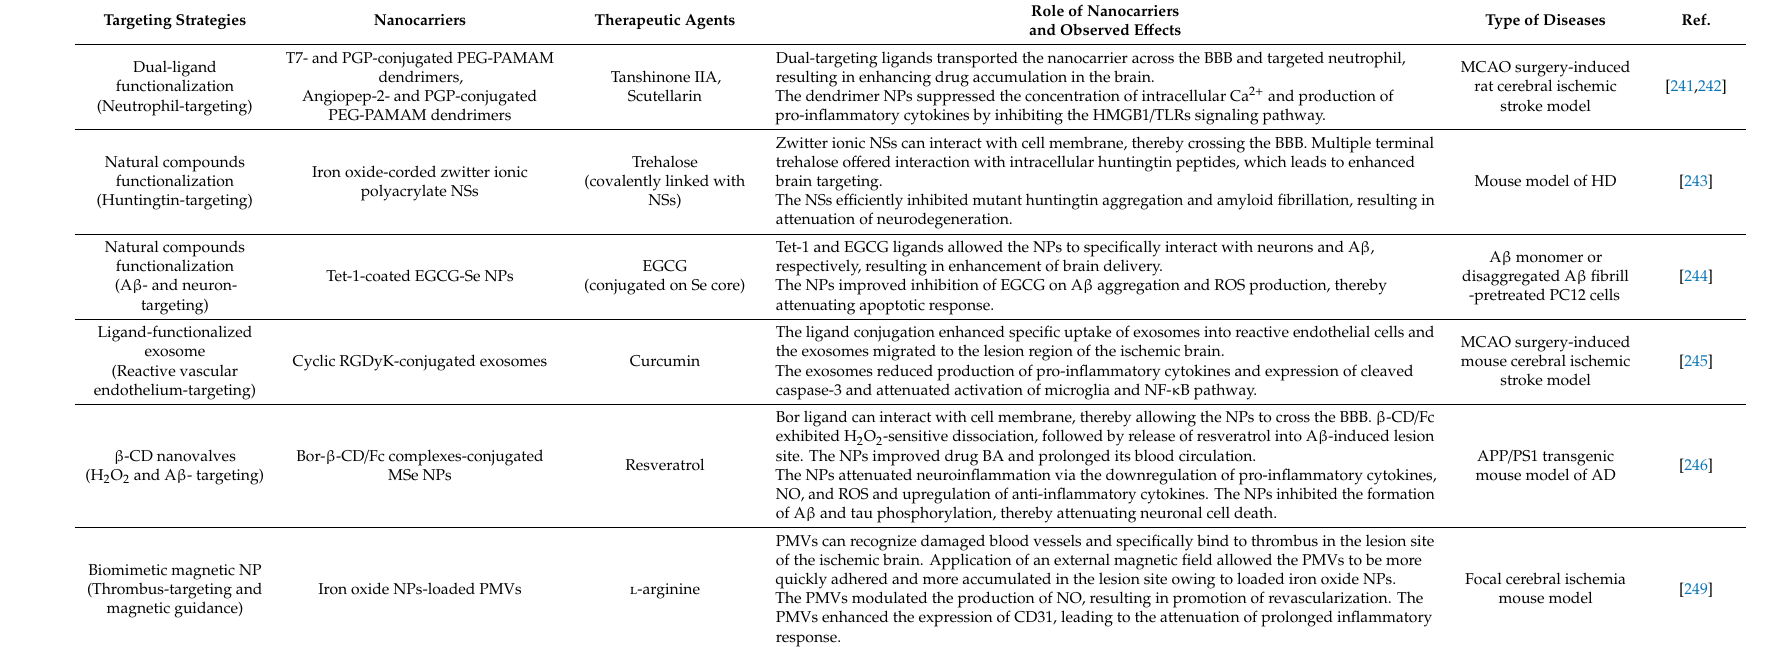
Table 4. Novel CNS inflammation-targeted strategies using nanocarriers containing natural